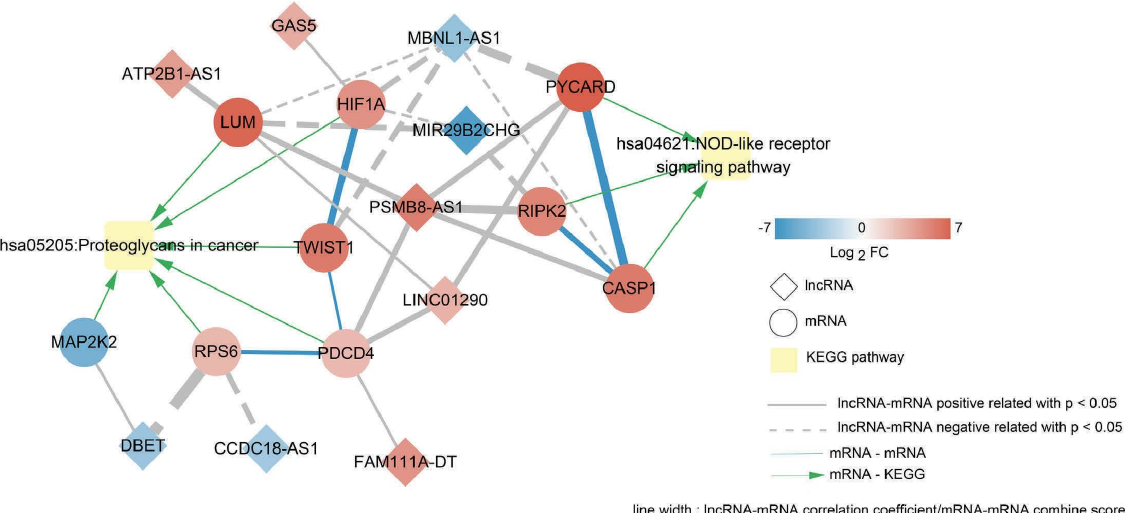
Figure 5: Construction of a DMD-related lncRNA-mRNA pathway network composed of two KEGG pathways, nine DMD-related DEMs, and nine DELs. Diamonds, circles, and yellow squares represent DELs, DMD-related DEMs, and KEGG pathways,